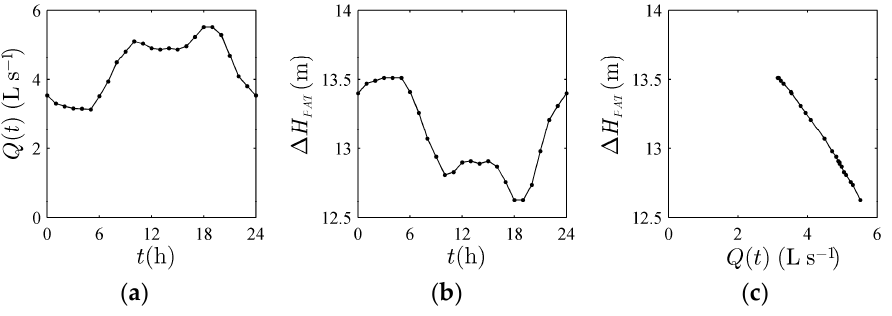
Figure 10. Time series of flow ( a ) and head loss ( b ) through the valve; pattern ∆ H , Q ( t ) ( c ).